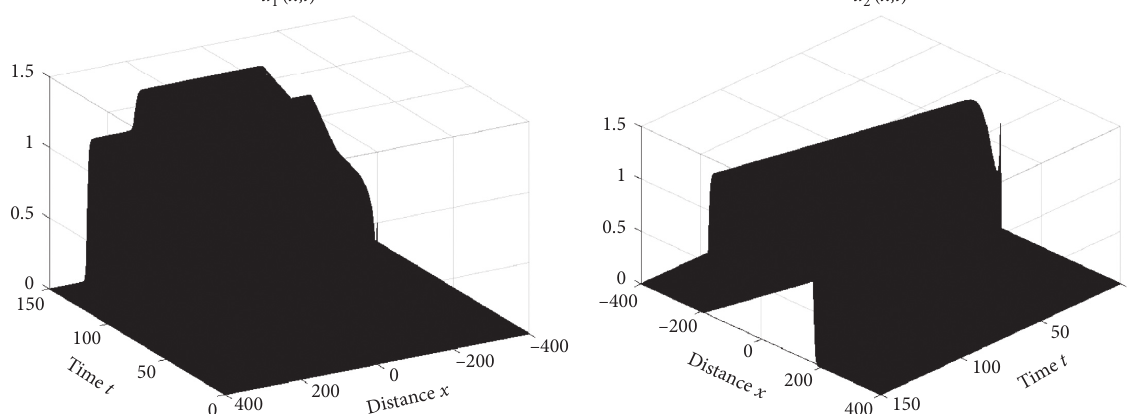
Figure 1: Simulation of ( u